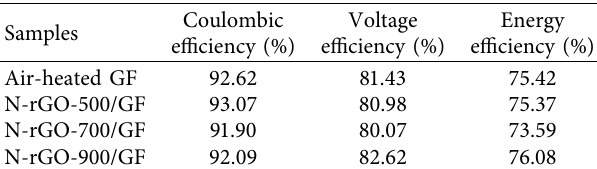
Table 6: Efficiency of cells equipped with different